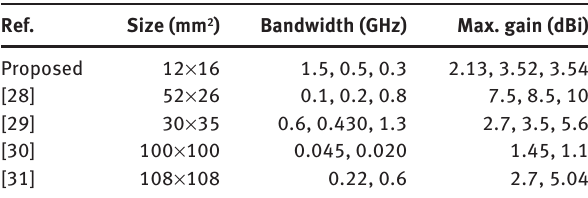
Table 1 Comparison between the proposed and some similar exist- ing